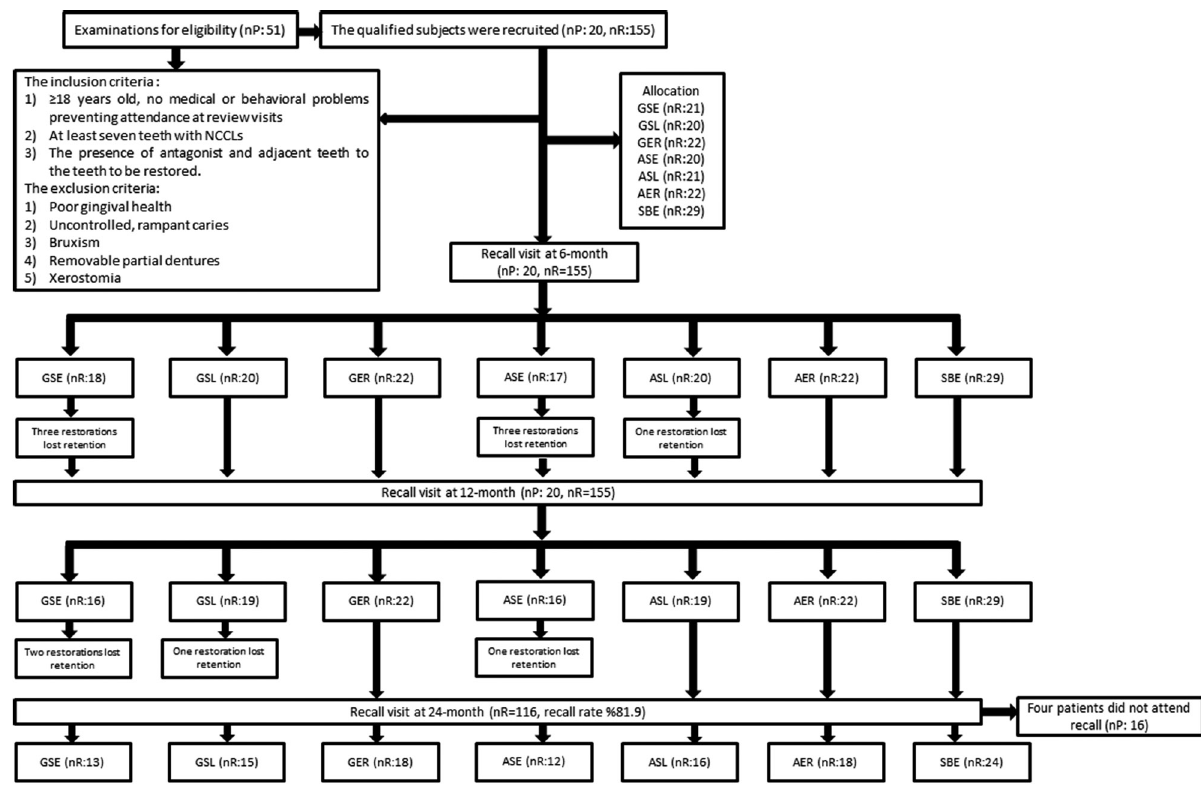
Figure 2- Flowchart of the study. nP: number of patients; nR: number of restorations; GSE: GLUMA Universal-self-etch; GSL: GLUMA Universal-selective etching; GER: GLUMA Universal-etch-and-rinse; ASE: All-Bond Universal-self-etch; ASL: All-Bond Universal-selective etching; AER: All-Bond Universal-etch-and-rinse; SBE: Single